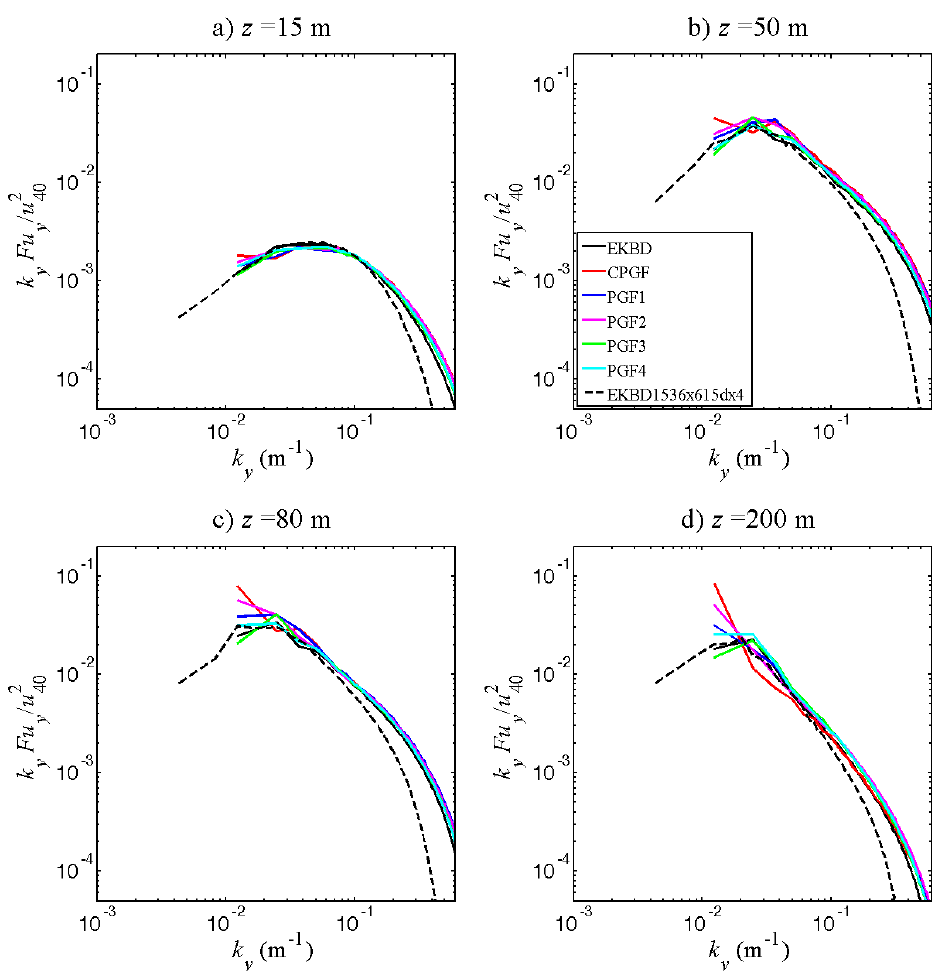
Figure 12. Spectral analysis of the u -velocity component for the wildfire-precursor simulations (512 m × 512 m × 615 m) and EKBD1536x615dx4 for reference, at ( a ) z = 15 m, ( b ) z = 50 m, ( c ) z = 80 m and ( d ) z = 200 m. The black-point line represents the − 2/3 power line.